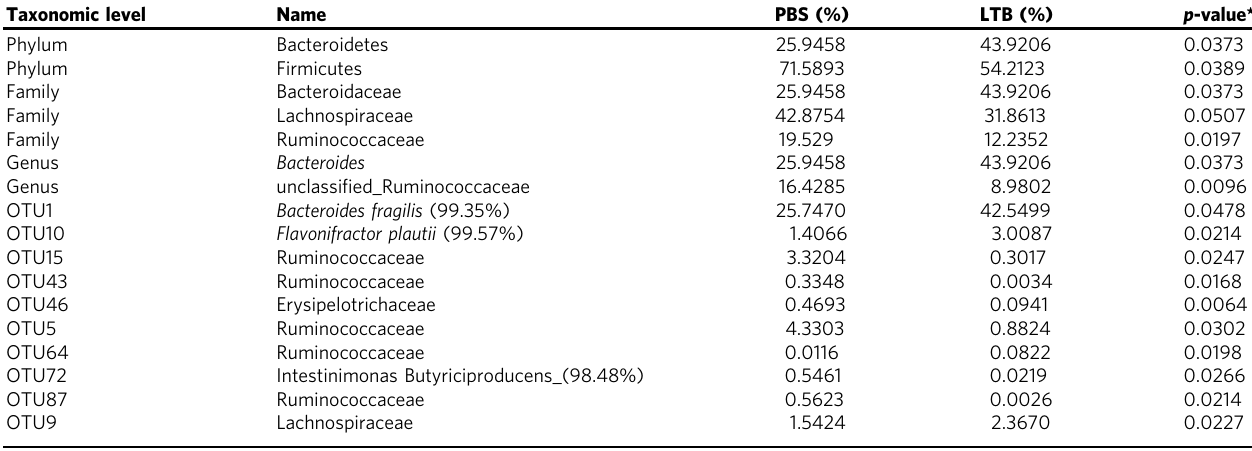
Table 2 Relative abundance and p -values of statistically signi fi cant changes in taxa caused by administration of LTB Taxonomic